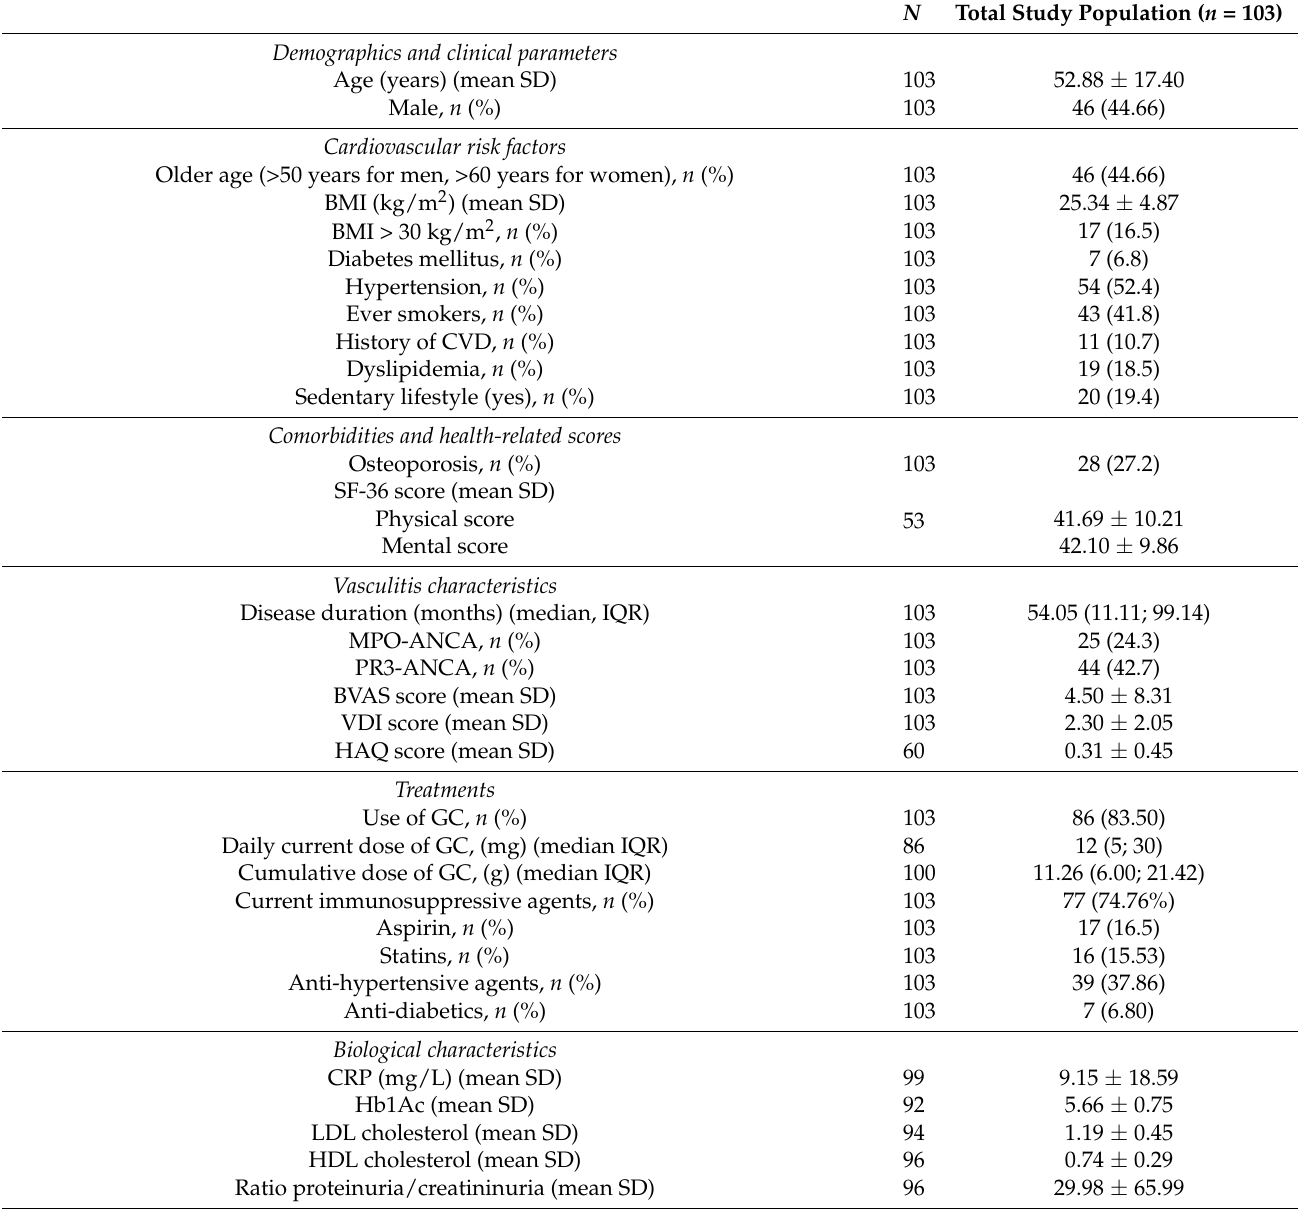
Table 1. Baseline demographic, clinical, biological, and functional characteristics of the study population from the OSTEO- VAS cohort.